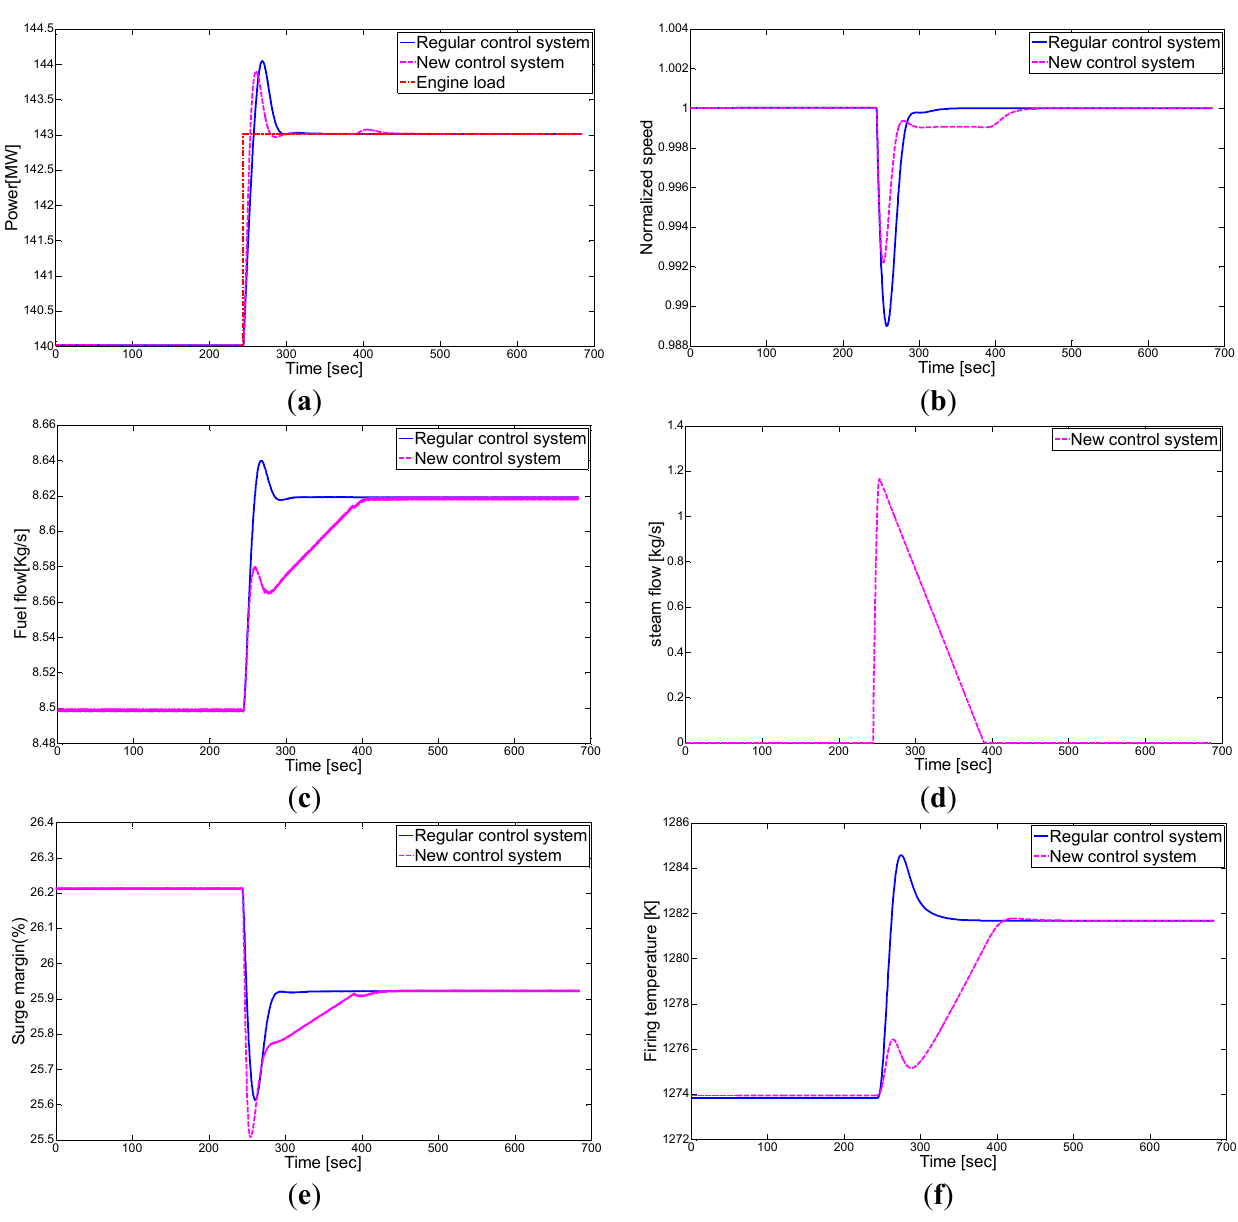
Figure 6. Comparison between the new control system and regular gas turbine control system in island mode-steam injection controller setting (dead band upper limit and lower limit = 0.001, −∞ , gain = 20, saturation limit = 0.3): ( a ) power; ( b ) speed; ( c ) fuel flow; ( d ) steam flow; ( e ) surge margin; and ( f ) firing